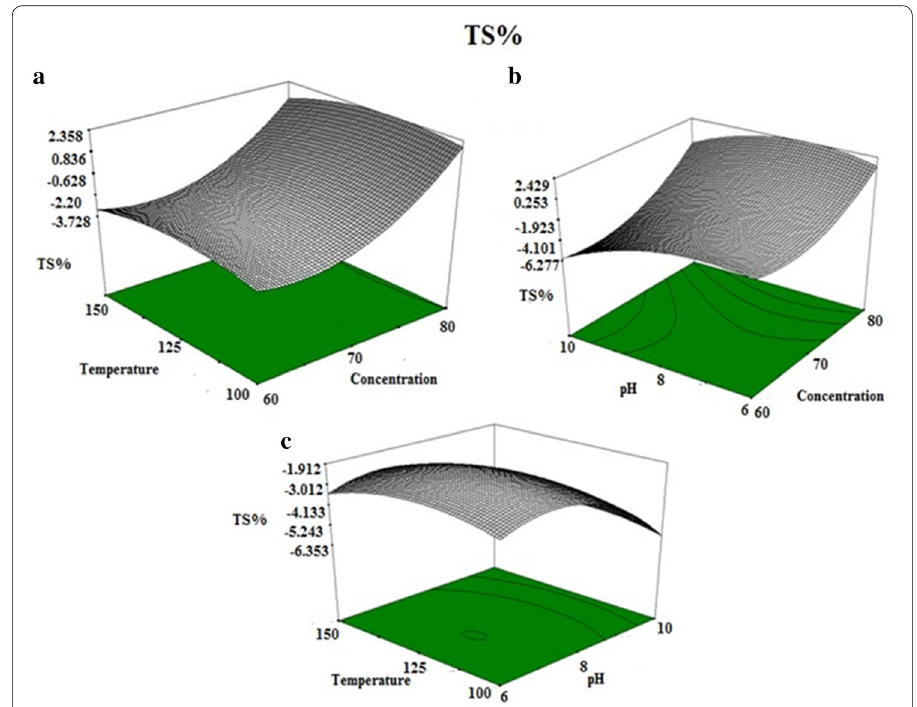
Fig. 5 Effect of a temperature and concentration, b pH and concentration, c pH and temperature on